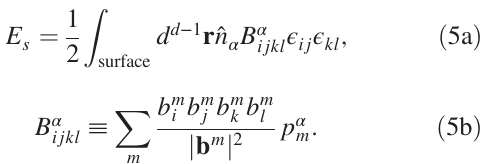
FIG. 2. (a) On a periodic system, we apply a particular strain (green) or compress (red). (b) The system then relaxes by projecting onto the space of self-stresses that mostly capture particles displacing over short distances but reducing the energy cost